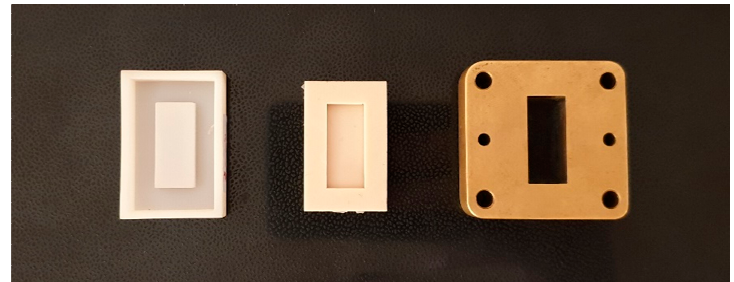
Figure 2. Master mold, silicone mold and spacer with sample.